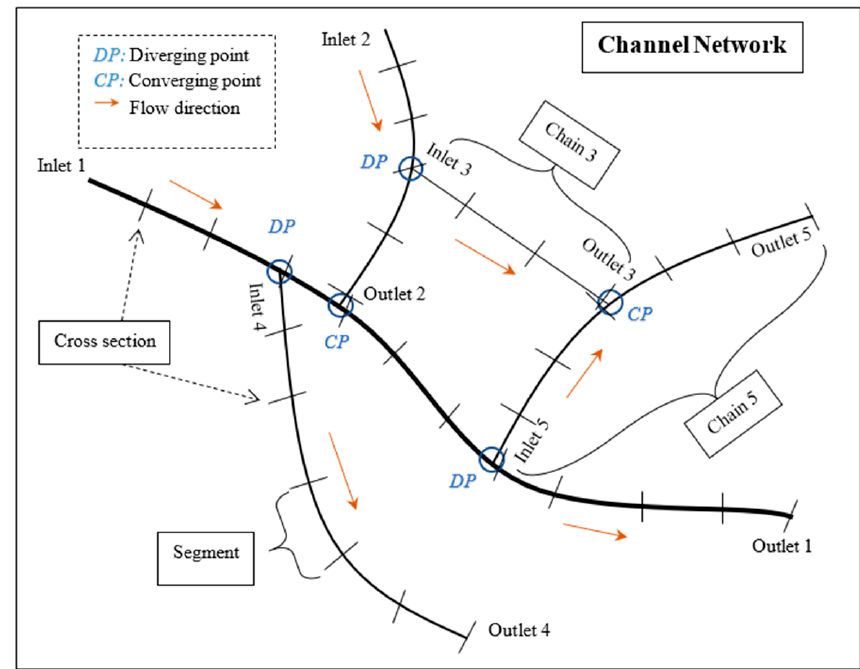
Figure 3. A generalized representation of the channel network.